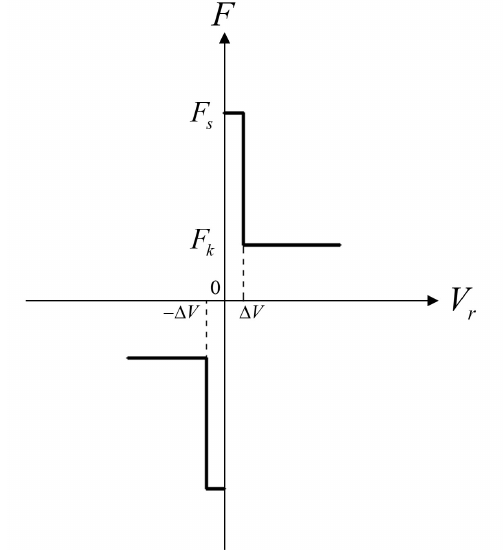
Figure 6. Karnopp friction